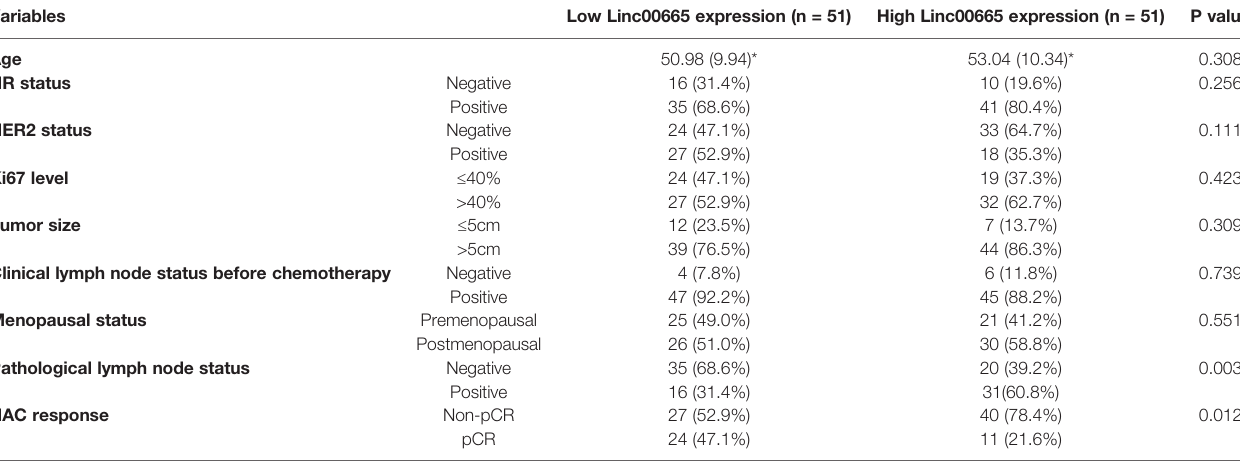
TABLE 1 | Correlation between Linc00665 expression and clinicopathological features in breast cancer.